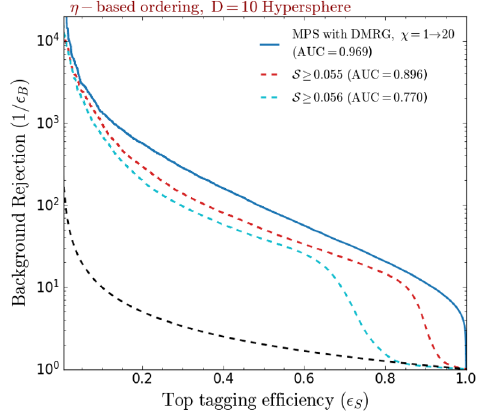
Figure 10 . Three types of network compression after training have been presented. The top left panel shows the ROC curve after introducing certain thresholds on the Schmidt values, the top right panel shows the same for entropy change based network compression (see the text for details), and the bottom panel shows the ROC curve for the compressed network with entropy